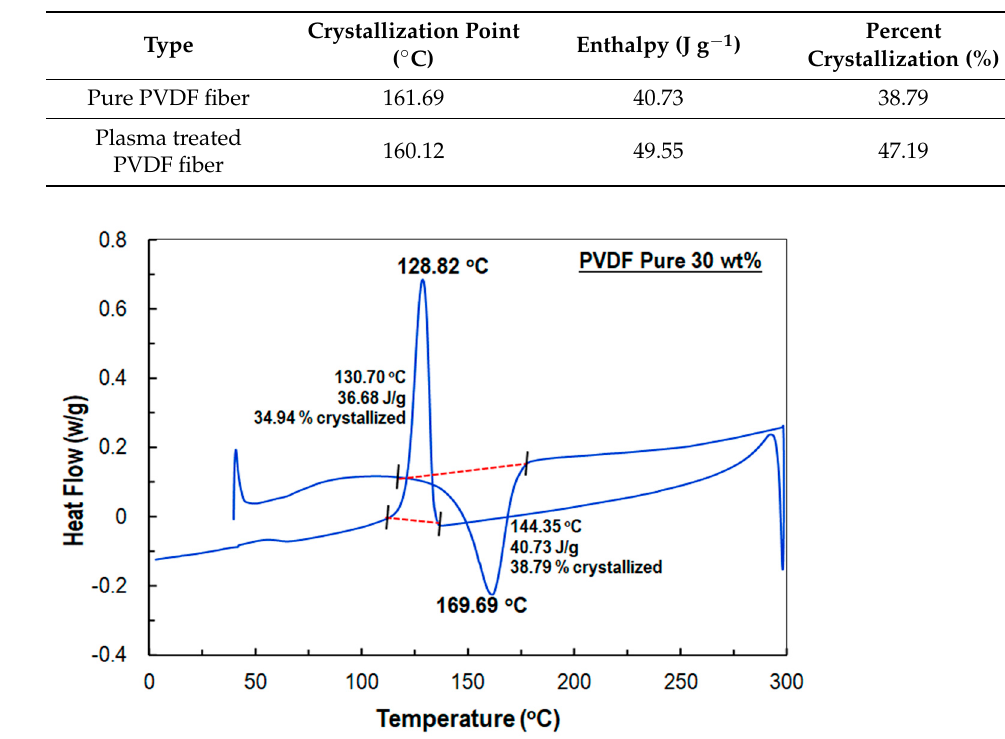
Table 1. Comparison of crystallization point, enthalpy, and crystallization percentage of a pristine and plasma treated PVDF fibers.